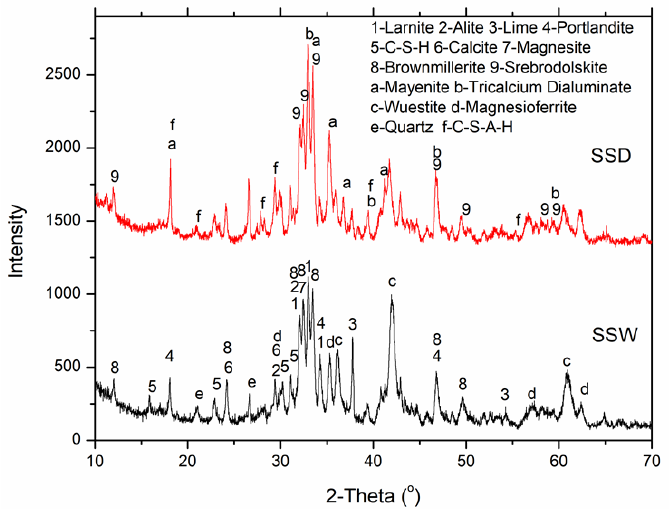
Figure 1. XRD of the steel slag powder (SSD) and steel slag mud (SSW).